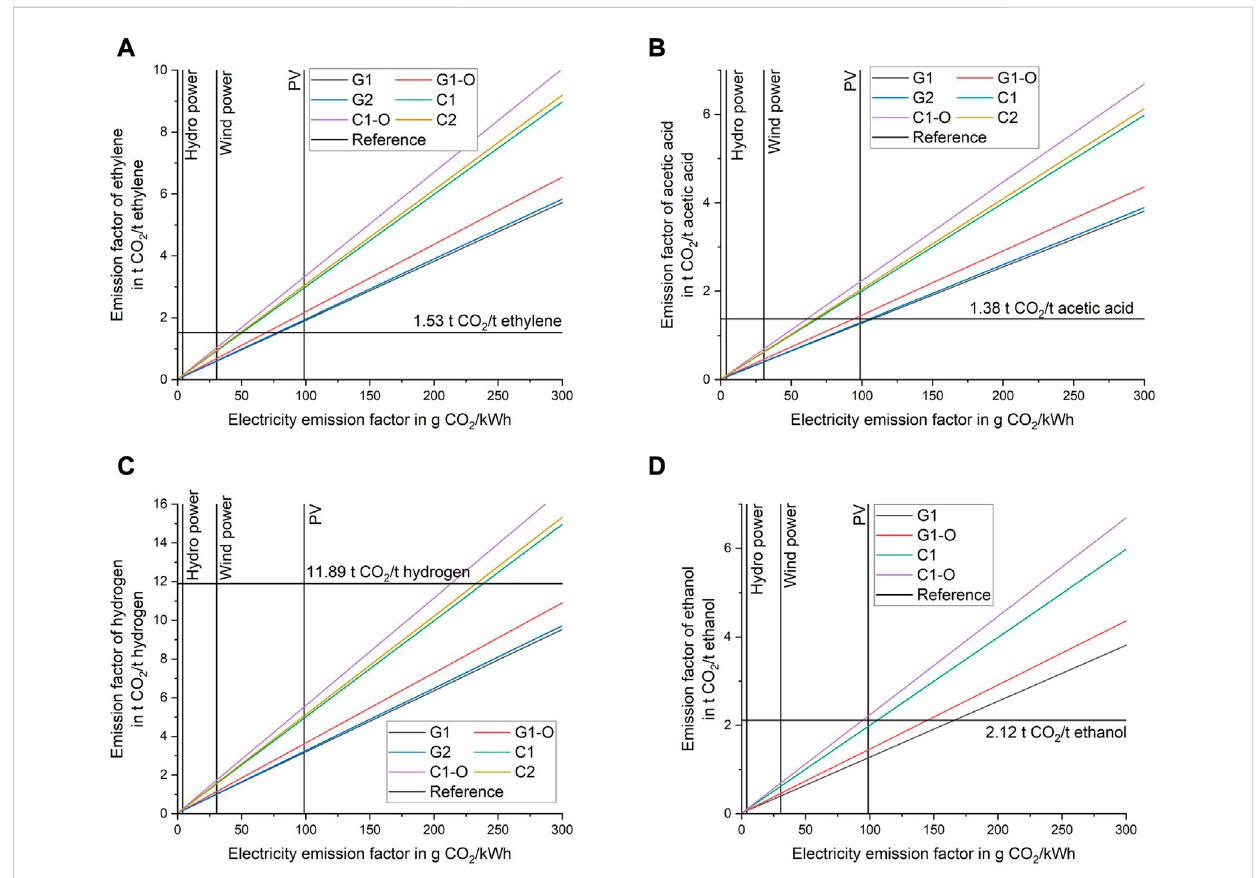
FIGURE 6 Impact of carbon intensity of electricity input on the CO 2 emission factor of ethylene (A) , acetic acid (B) , hydrogen (C) , and ethanol (D)